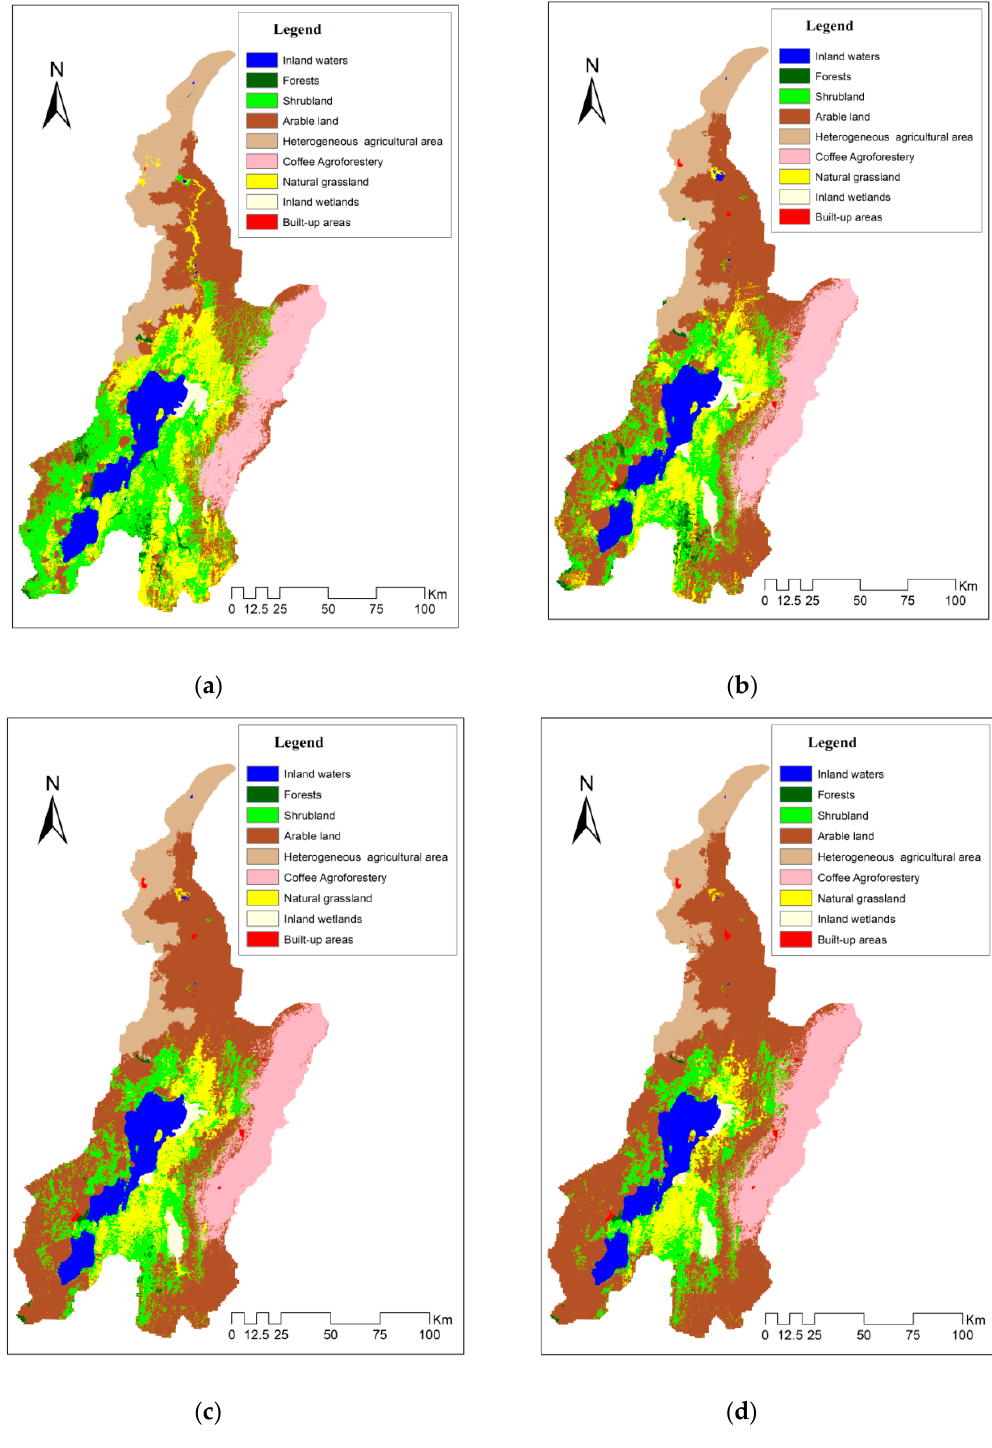
Figure 2. Observed LULC in the ACB in 1985 ( a ) and 2010 ( b ) and simulated LULC for 2030 ( c ) and 2050 ( d ).